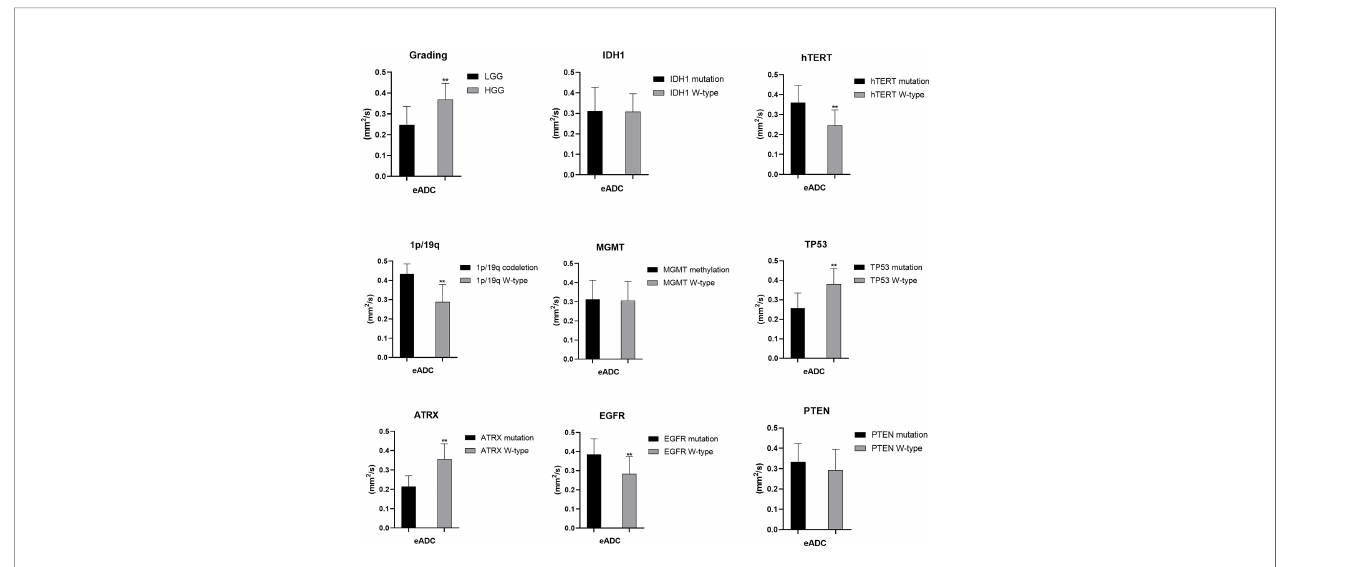
FIGURE 5 | Statistic results of grading, IDH1/2, 1p/19q, MGMT, hTERT, TP53, PTEN, EGFR, ATRX mutations status and eADC (**P <